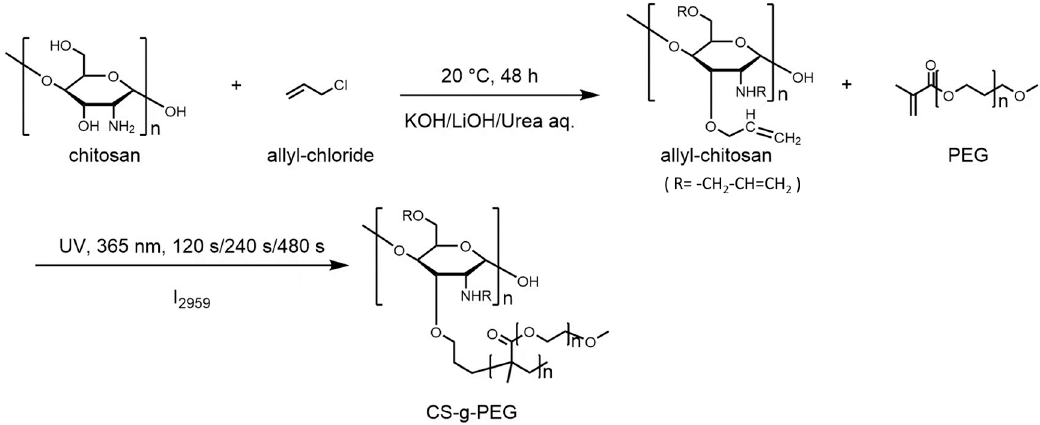
Scheme 1. Reaction mechanism of allyl-modified chitosan and CS-g-PEG.